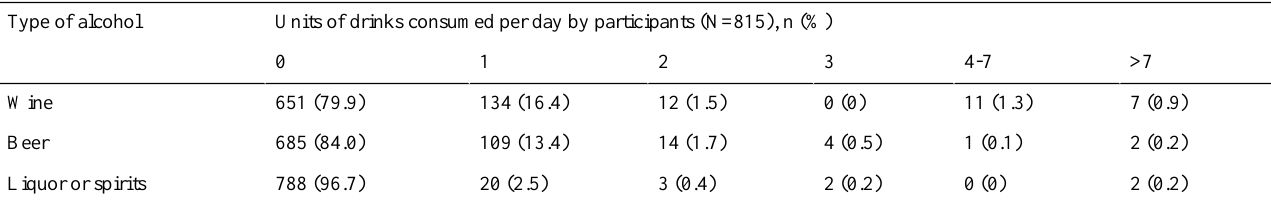
Table 2. Different types of alcohol consumption over the preceding 7 days by 815 students and employees in four divisions of a Swiss university of applied sciences during the spring 2020 COVID-19